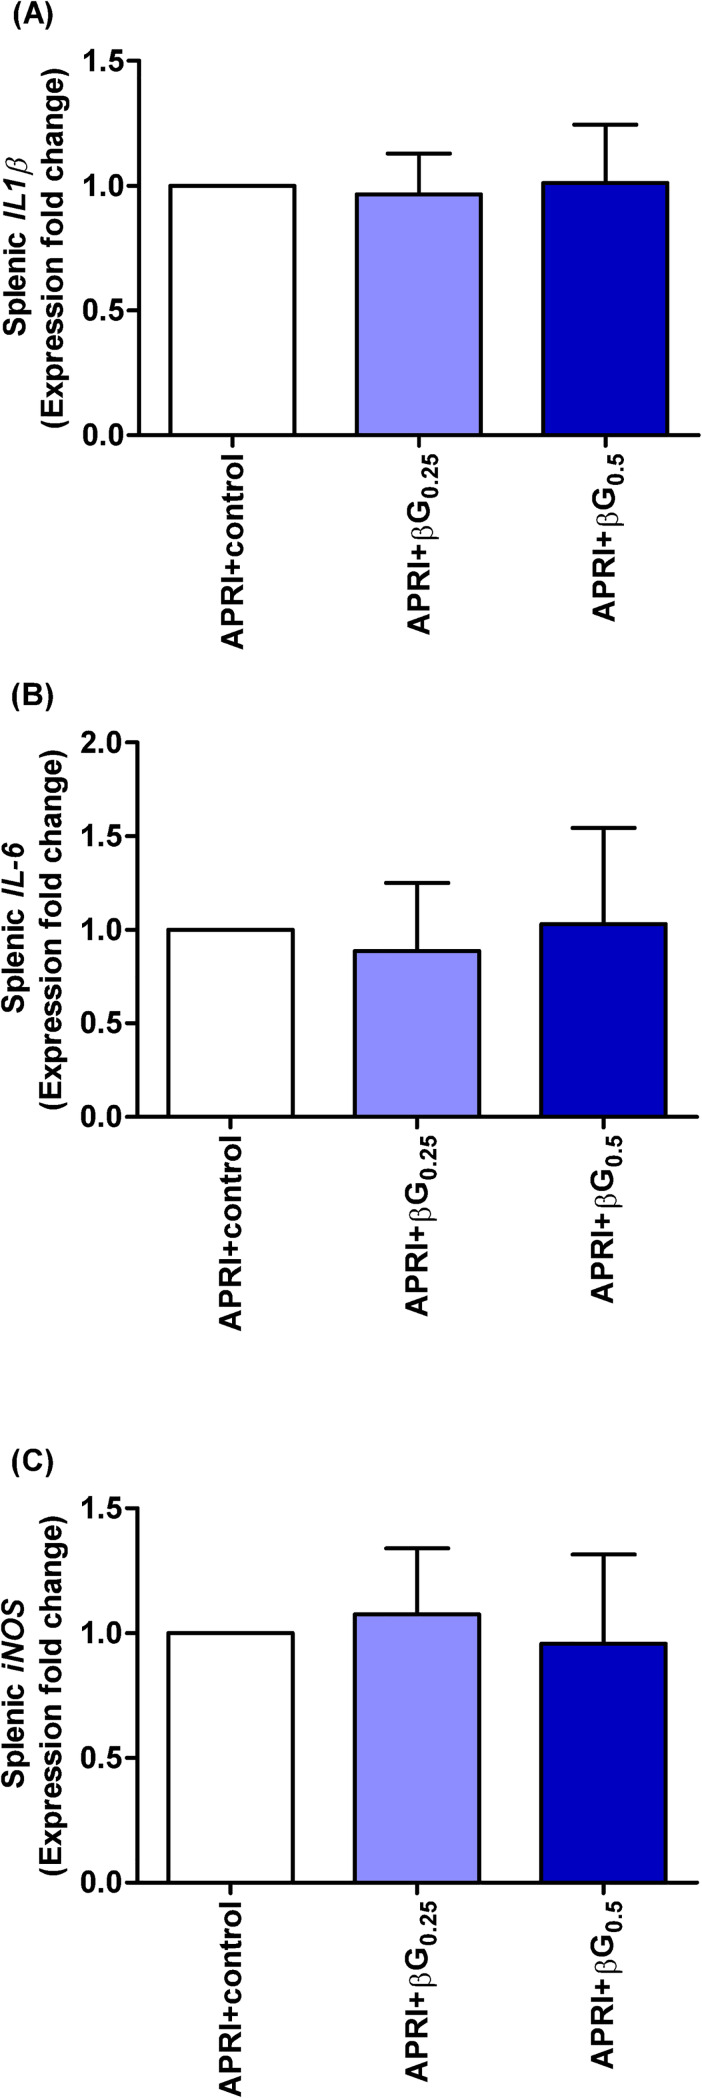
RT-PCR validation of the splenic (A) interleukin-1beta (IL-1β), (B) interleukin-6 (IL-6), and (C) inducible nitric oxide synthase (iNOS) genes in APRI rabbits. Statistical analysis was performed using one-way ANOVA and Tukey's post hoc test for multiple comparisons.